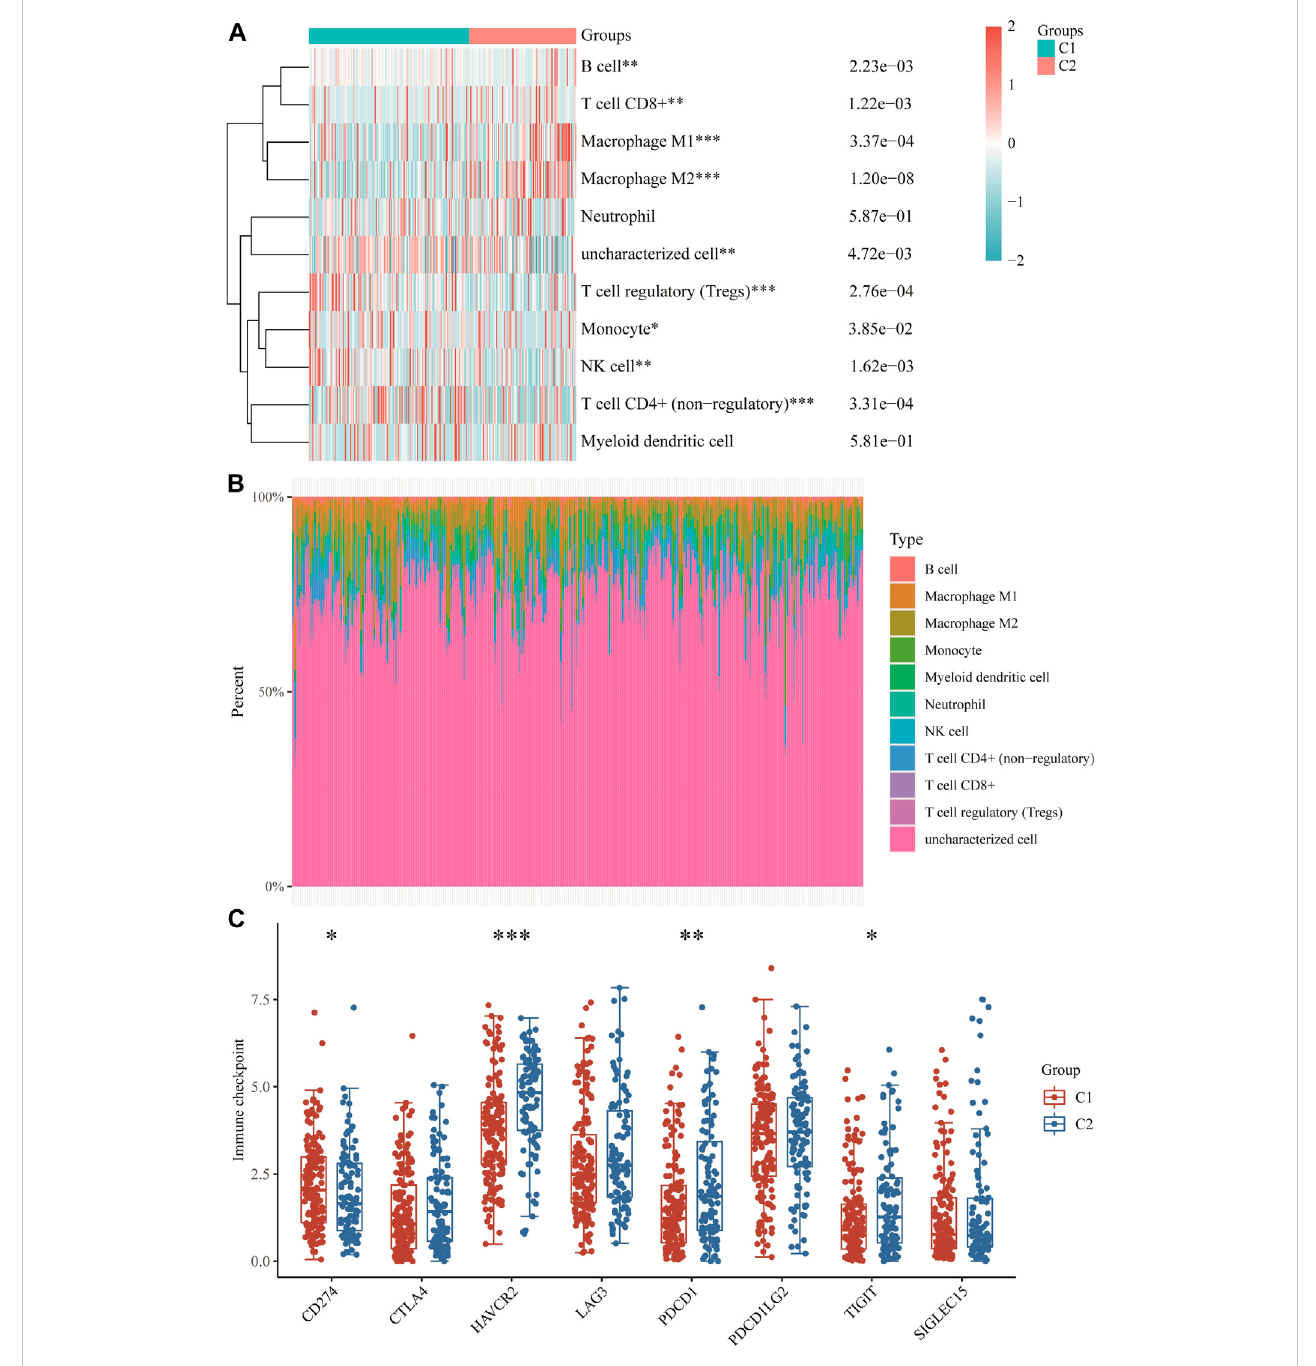
FIGURE 5 Immune in fi ltration estimated by QUANTISEQ algorithm and the expression distributions of eight immune checkpoint-related genes in sarcoma subgroups. (A) Immune cell score heat map. (B) Proportions of eleven types of immune cells shown for each sarcomatous patient by a histogram. (C) The expression distributions of eight immune checkpoint-related genes in sarcomatous subgroups. * p < 0.05; ** p < 0.01; *** p <